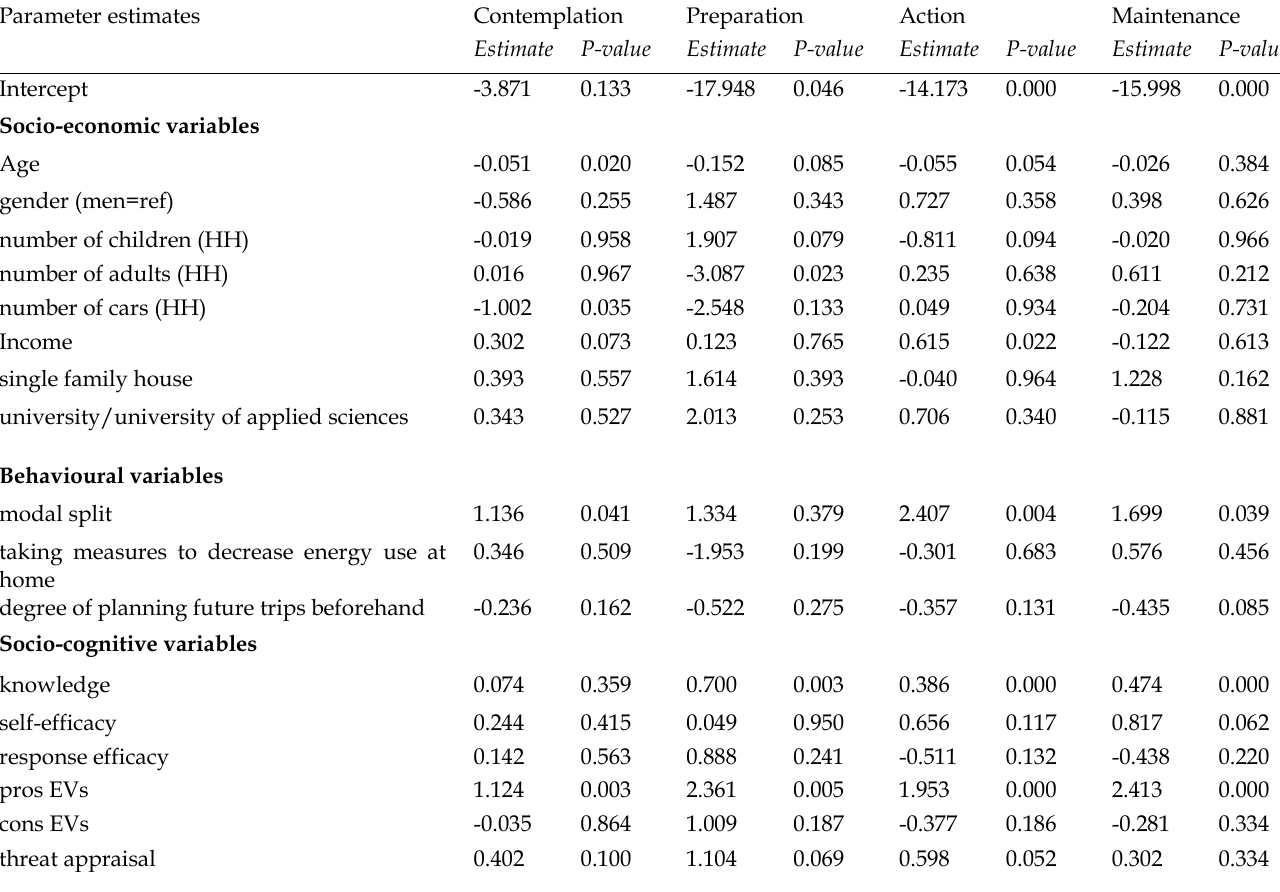
Table 2. Output model 1: MNL-model stage-of-change with socio-cognitive variables